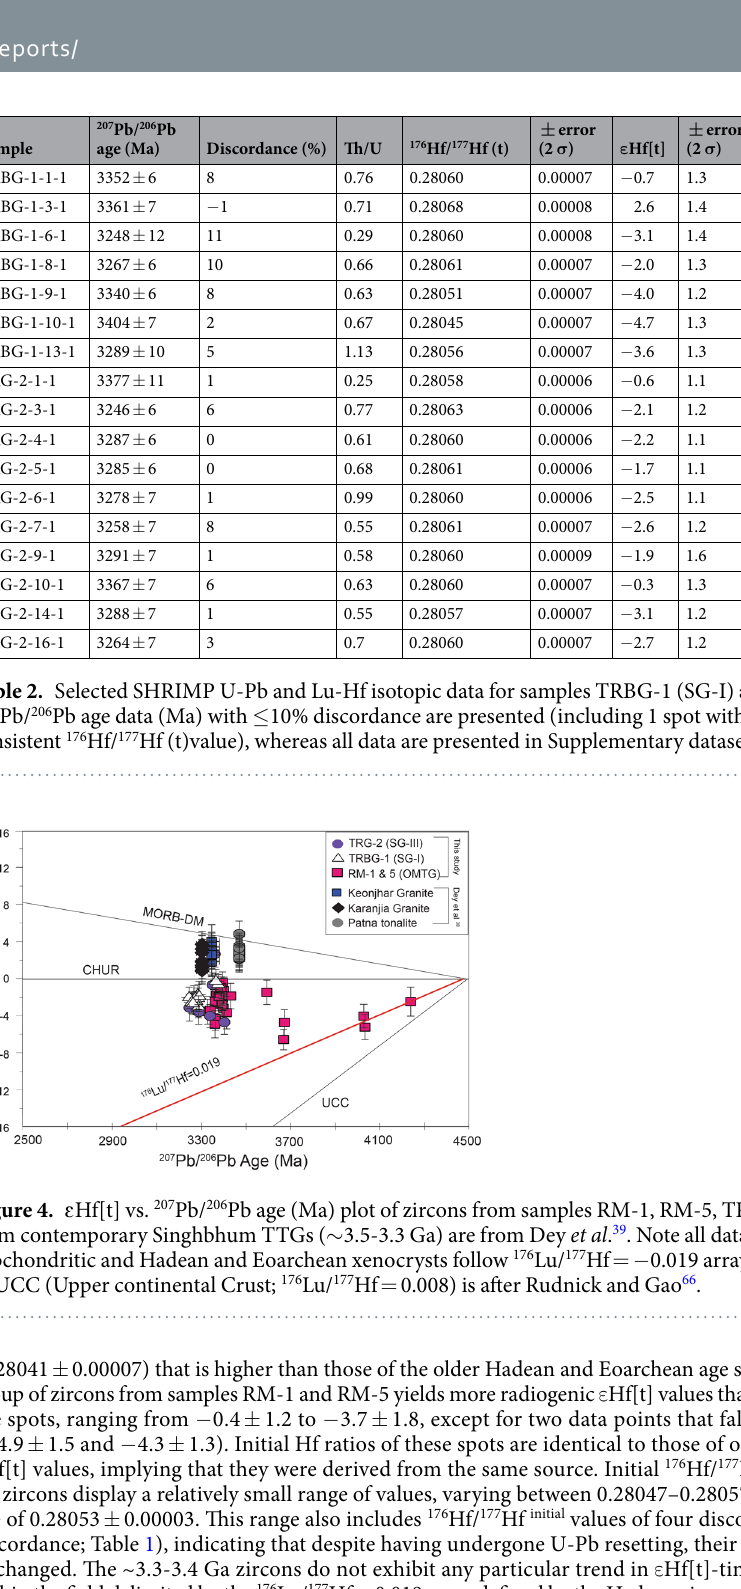
7 Scientific REPoRTS | (2018) 8:7069 | DOI:10.1038/s41598-018-25494-6